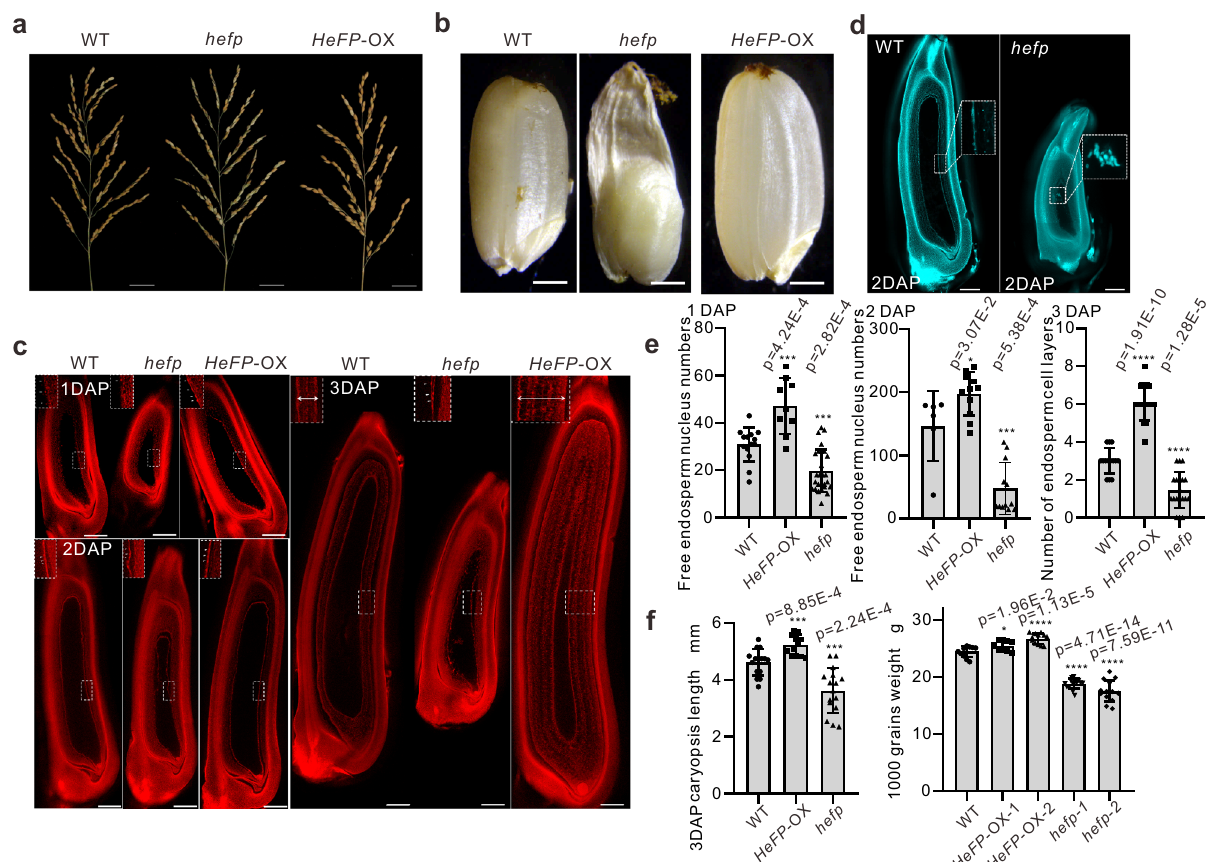
Fig. 4 Phenotype analysis of WT, hefp , and HeFP -OX plants. a The panicles of WT, hefp , and HeFP -OX plants. Scale bars, 3 cm. b The seeds of WT, hefp , and HeFP -OX plants. Scale bars, 1 mm. c Confocal laser scanning microscopy of developing caryopses stained with Eosin B in WT, hefp , and HeFP -OX endosperm. Scale bars, 50 µ m. d Confocal micrograph of caryopses at 2 DAP stained with Propidium Iodide in WT and hefp caryopses. Scale bars, 200 µ m. e The number of free endosperm nuclei in WT, HeFP -OX, and hefp plants at 1DAP ( n = 14, 9, 27 caryopsis) and 2DAP ( n = 6, 11, 12 caryopsis), and the number of endosperm cell layers in WT, HeFP -OX, and hefp plants at 3DAP ( n = 14, 15, 19 caryopsis). Values are the means ± SD. f The caryopsis length of WT, HeFP -OX, and hefp plants at 3DAP ( n = 15, 12, 16 caryopsis) and the 1000 grains weight of mature seeds in WT, HeFP -OX-1, HeFP -OX-2, hefp -1 and hefp -2 plants ( n = 11, 10, 12, 15, 14 plants). Values are the means ± SD. Signi fi cant differences were identi fi ed at the 5% (*), 1% (**), 0.1% (***) and <0.01% (****) probability levels using two-tailed paired t fi rst exon (1 – 330 nt), and the rest of MISSEN as MISSEN- e (331 – 991 nt) (Fig. 3i) and found that the fi rst exon of MISSEN ( MISSEN -d) is suf fi cient for the binding of HeFP (Fig. 3j). The results indicated that the fi rst exon of the lncRNA is important for it to action.